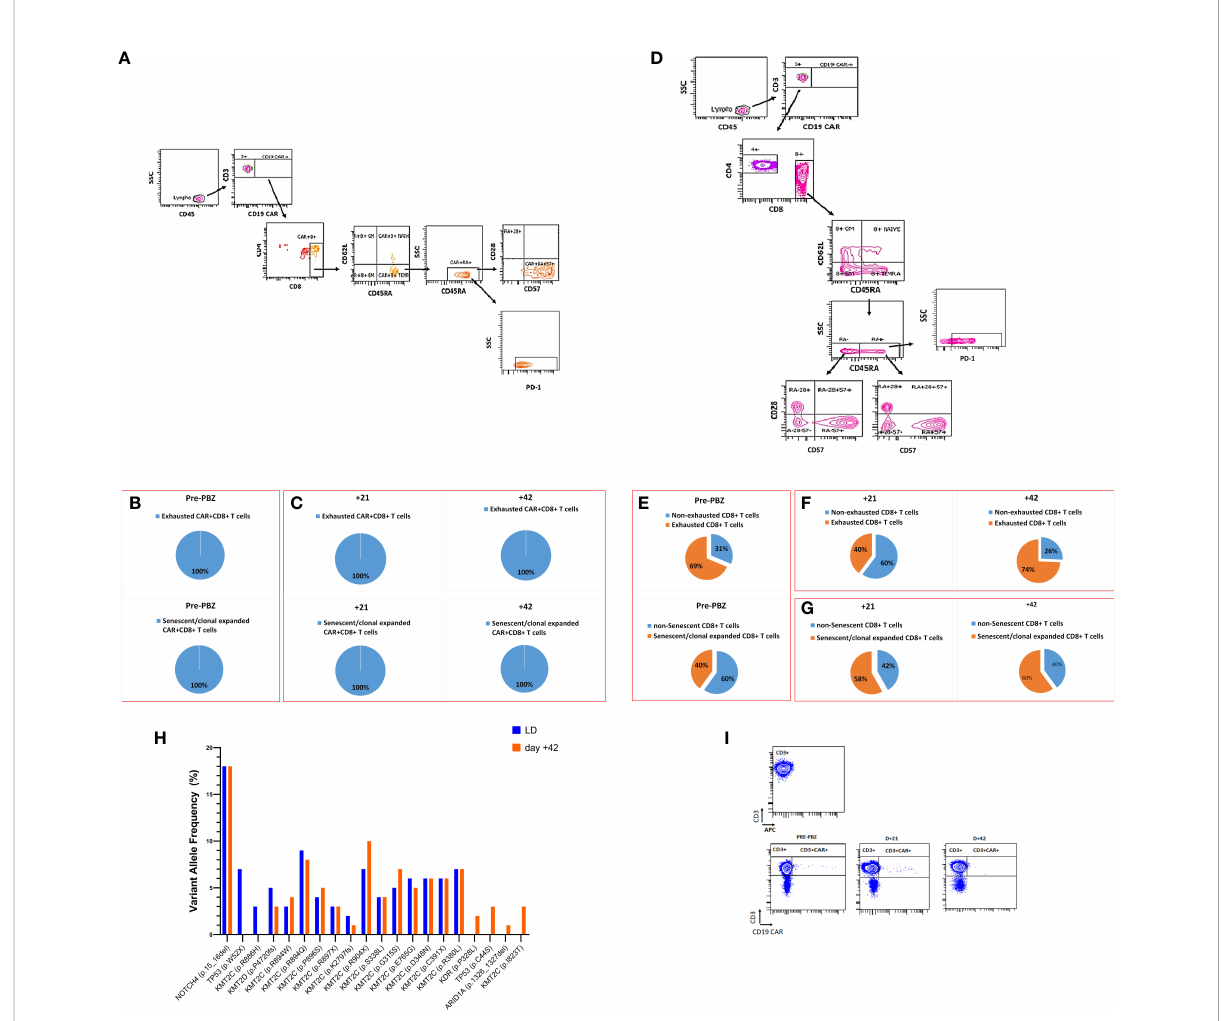
FIGURE 2 Flow cytometric analysis of peripheral blood CAR + and CAR-non expressing T cell compartment. (A) Gating strategy used to identify the senescent/clonal expanded and exhausted CD8 + T cells in the CAR + compartment. Pie charts report the percentage of exhausted and senescent/clonal expanded CAR + CD8 + T cells at (B) pre-PBZ and (C) D+21 and D+42 after PBZ. (D) Gating strategy used to identify the senescent/clonal expanded and exhausted CD8 + T cells in the non-CAR CD8 + T cell compartment. Pie charts report the percentage of (E) exhausted and senescent/clonal expanded CAR - CD8 + T cells at pre-PBZ, (F) exhausted and (G) senescent/clonal expanded CAR - CD8 + T cells at D+21 and D+42 after PBZ. (H) Identi fi cation of pathogenetic genetic alterations in the ccfDNA at LD (blu bars, n=16) and at day +42 (orange bars, n=18) and relative VAF. (I) Dot plots display CD3 + and CD3 + CD19 CAR + T cell populations before and after